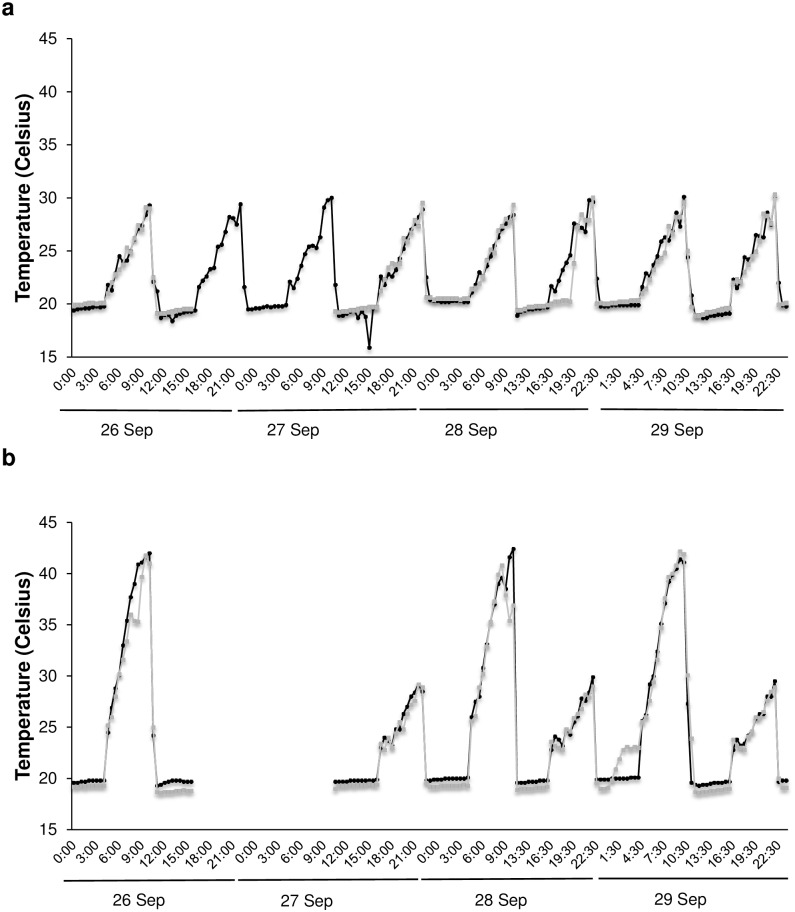
Temperature profiles in the mesocosms.Temperature profiles in the four experimental tanks (A-D): a) Control conditions (tank A: black line; tank B: grey line); b) Heatwave conditions (tank C: black line; tank D: grey line). Missing values between 1600h on 26 September and 1000h on 27 September are due to a failure in the recording system.